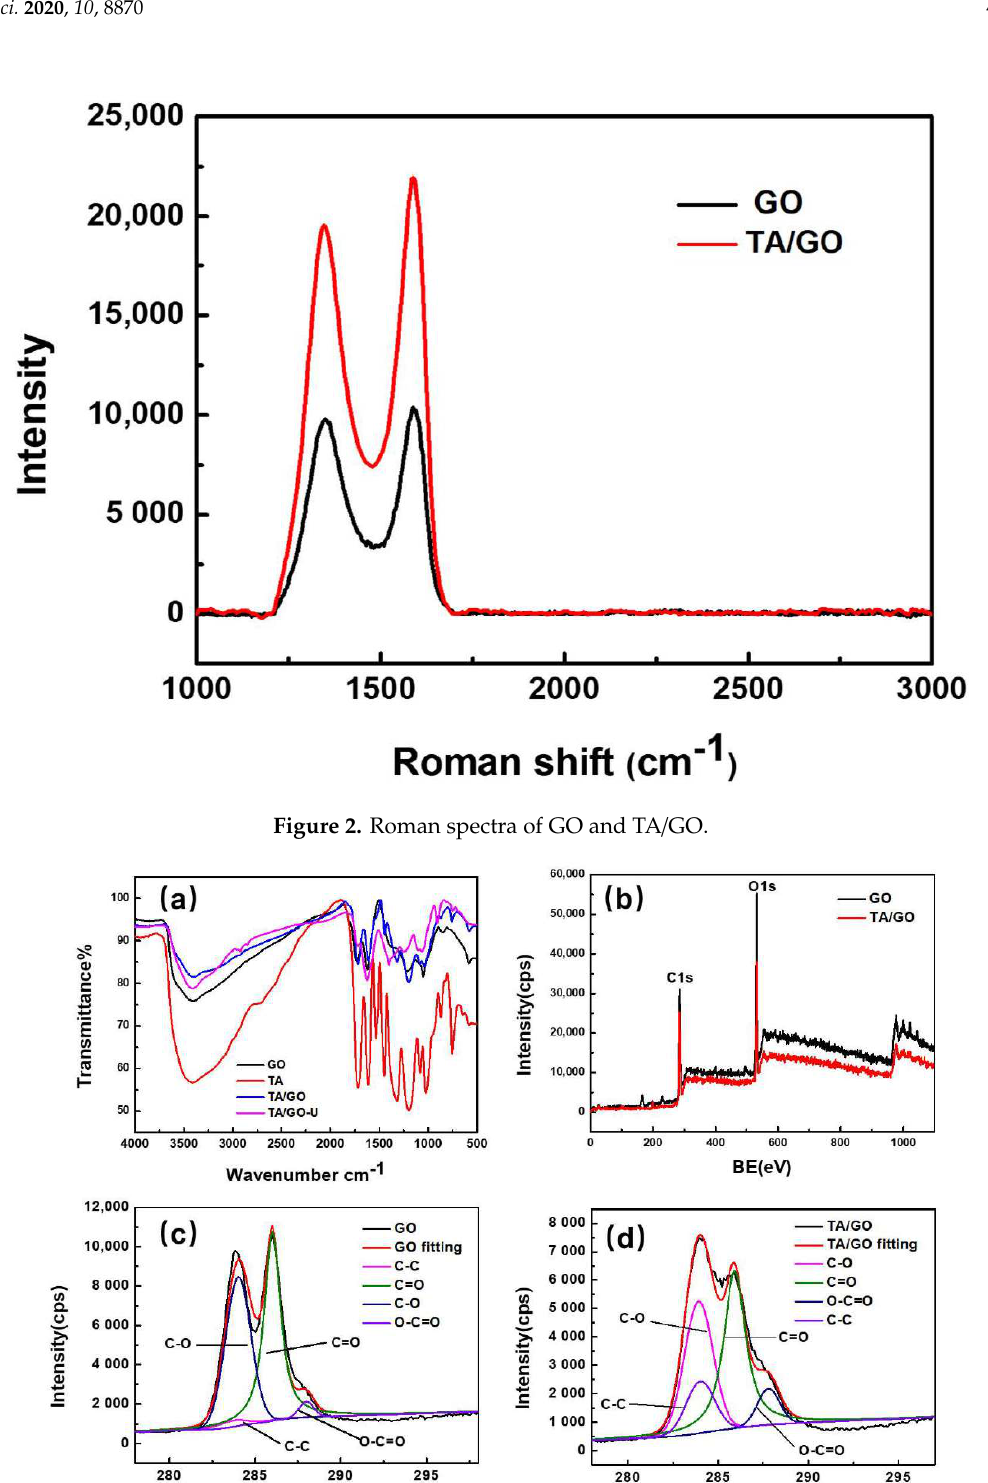
Figure 3. ( a ) The FTIR of GO, TA, TA / GO, and TA / GO-U(VI); ( b ) XPS full survey spectra; ( c ) C1s XPS spectra of GO; ( d ) C1s XPS spectra of TA / GO